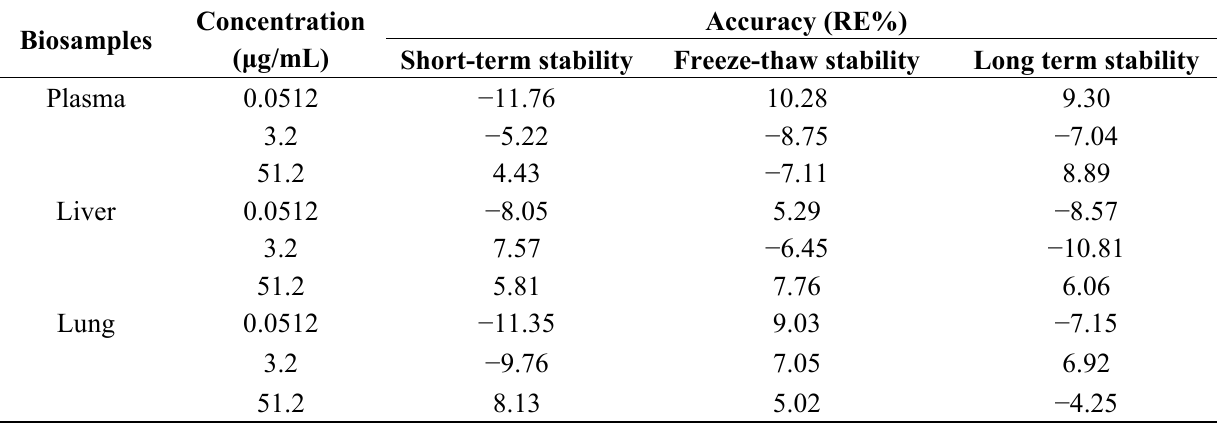
Table 3. Stability of PD in plasma, liver and lung samples of rats ( n = 6).